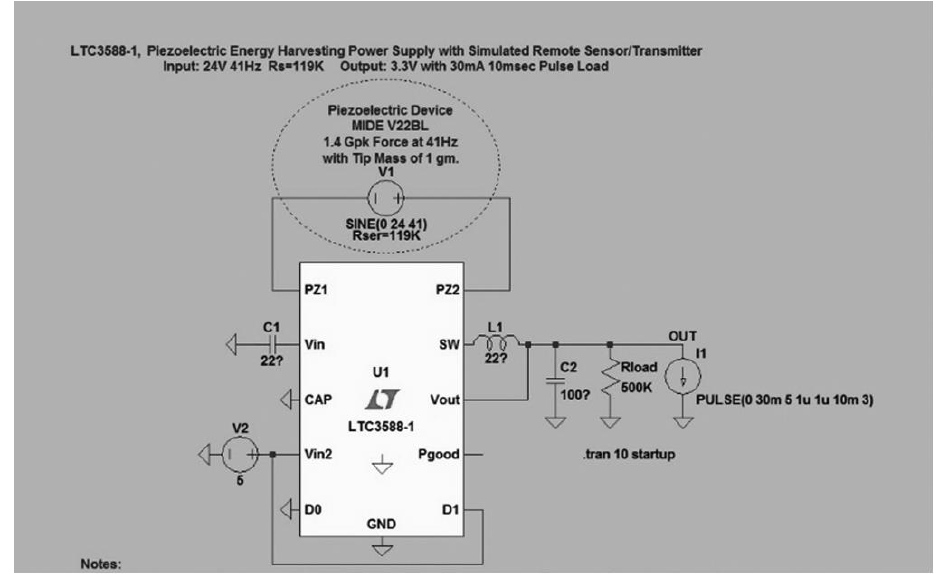
Figure 2. Schematic of energy harvesting circuit using piezoelectric device, obtained via LTspice.